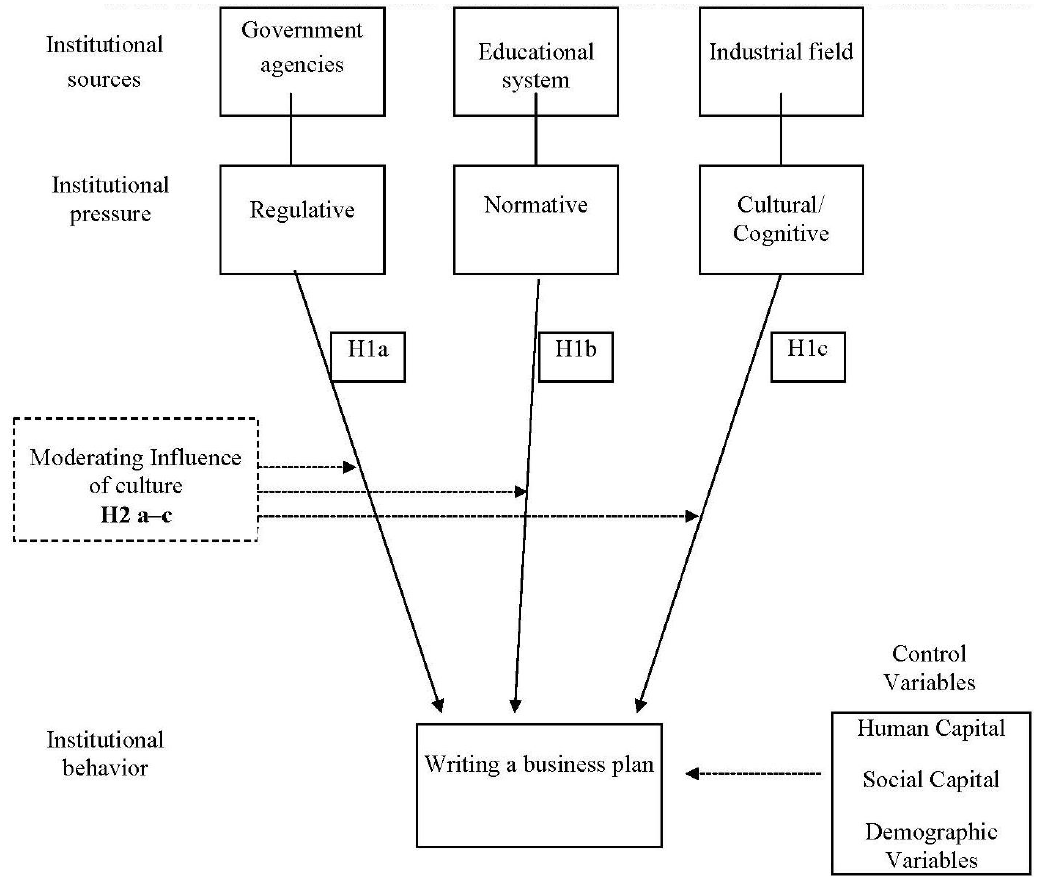
Figure 1. Institutional forces, sources and the moderating effects of culture on business